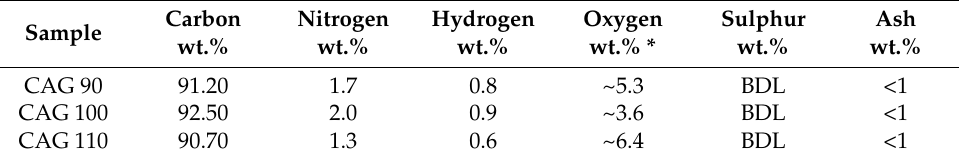
Table 4. Elemental analysis of selected carbon aerogels (CAG 90, CAG 100, and CAG 110). Sample